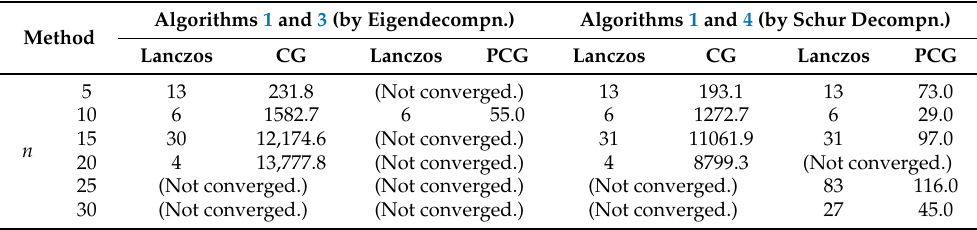
Table 6. Number of iterations of the Lanczos method and the average of numbers of iterations of the CG/PCG method in the case of the median of singular value of slightly symmetric matrix T with a = c = 1 and b = 0.1 in (9) for the shift (8). Algorithms 1 and 3 (by Eigendecompn.) Algorithms 1 and 4 (by Schur Decompn.) Method